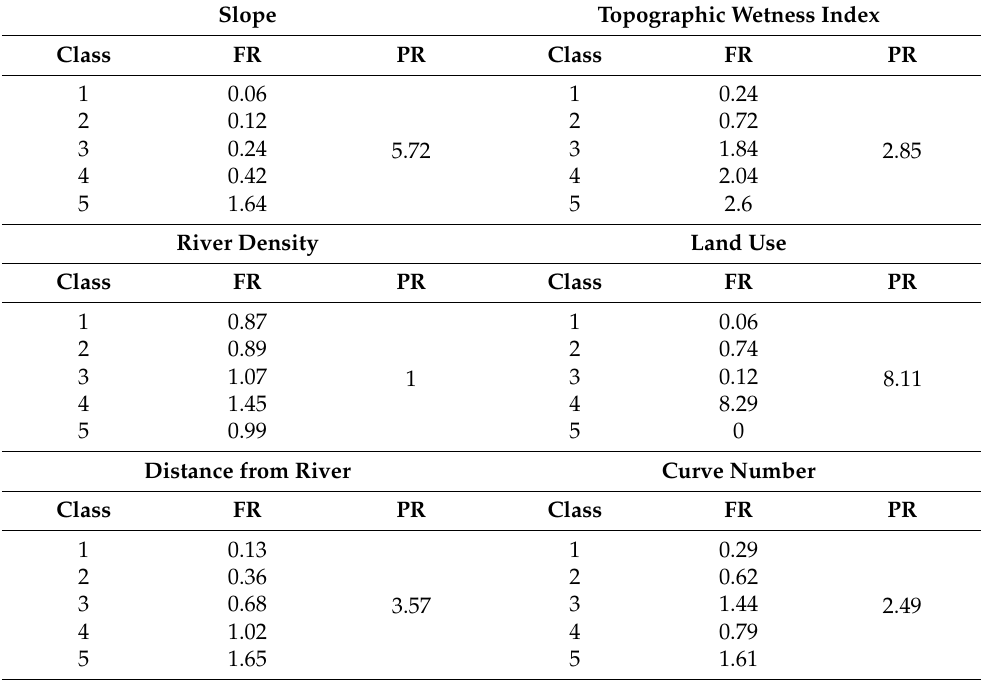
Table 7. Frequency ratios and predictive weights for the factors used in FR model for susceptibility analysis. Slope Topographic Wetness